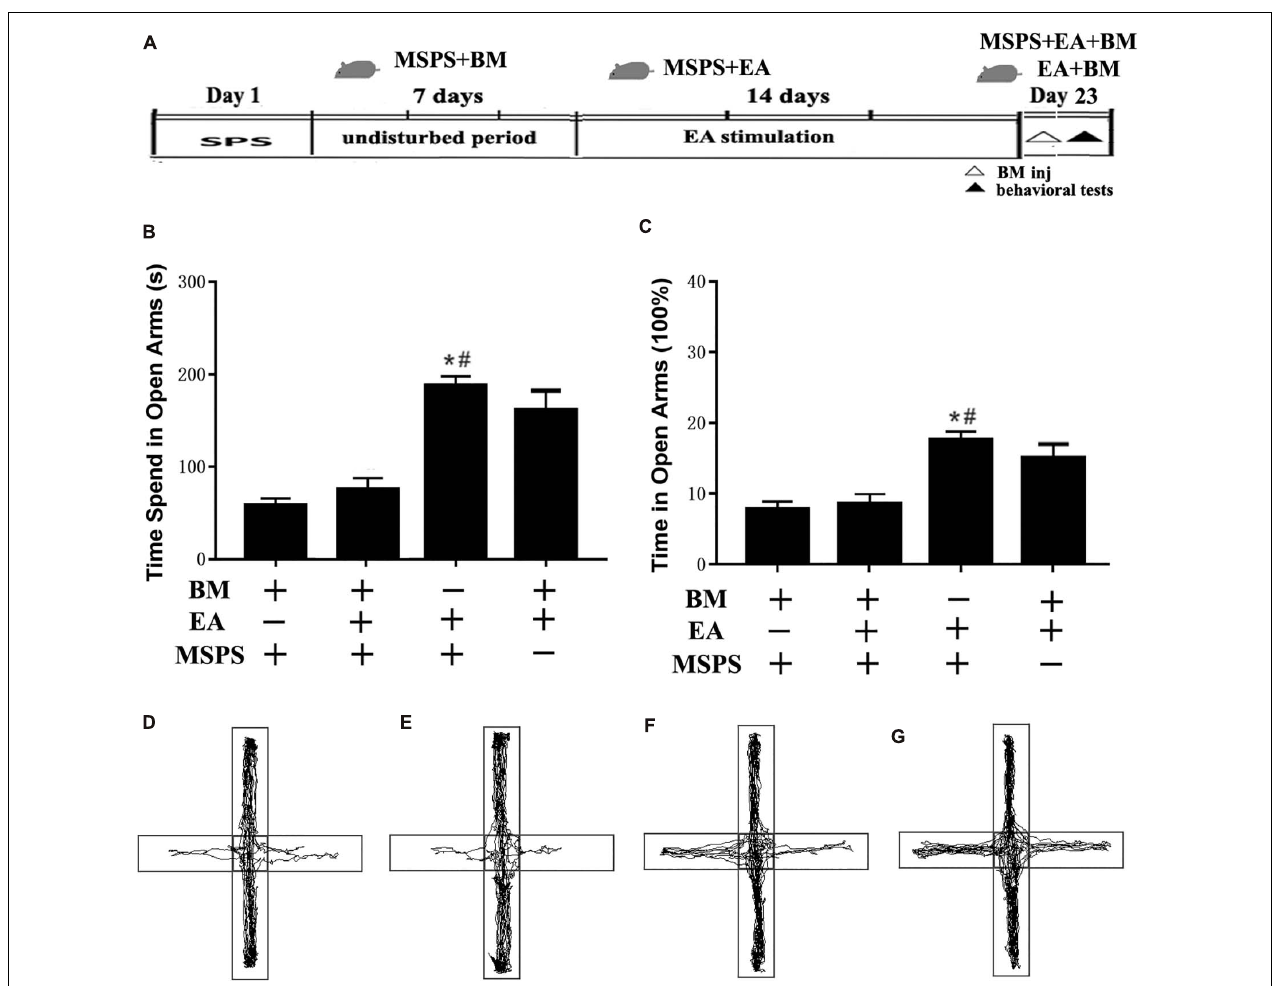
FIGURE 4 | Transient vmPFC inactivation disrupts the effects of EA on anxiety-like behaviors in MSPS model rats. (A) A timeline of MSPS modeling, EA treatment, stereotactic injection, and behavioral testing protocols. Briefly, MSPS modeling was performed on day 1. After a 7-day rest, rats were treated once per day as per an EA protocol (days 9 – 22). On day 23, rats were stereotaxically injected with artificial CSF (aCSF) or a 1.0 nmol/0.1 nmol mixture of baclofen and muscimol (BM) in the bilateral vmPFC immediately prior to behavioral testing. (B) Time spent in the open arms during elevated plus maze (EPM) testing for rats in the indicated